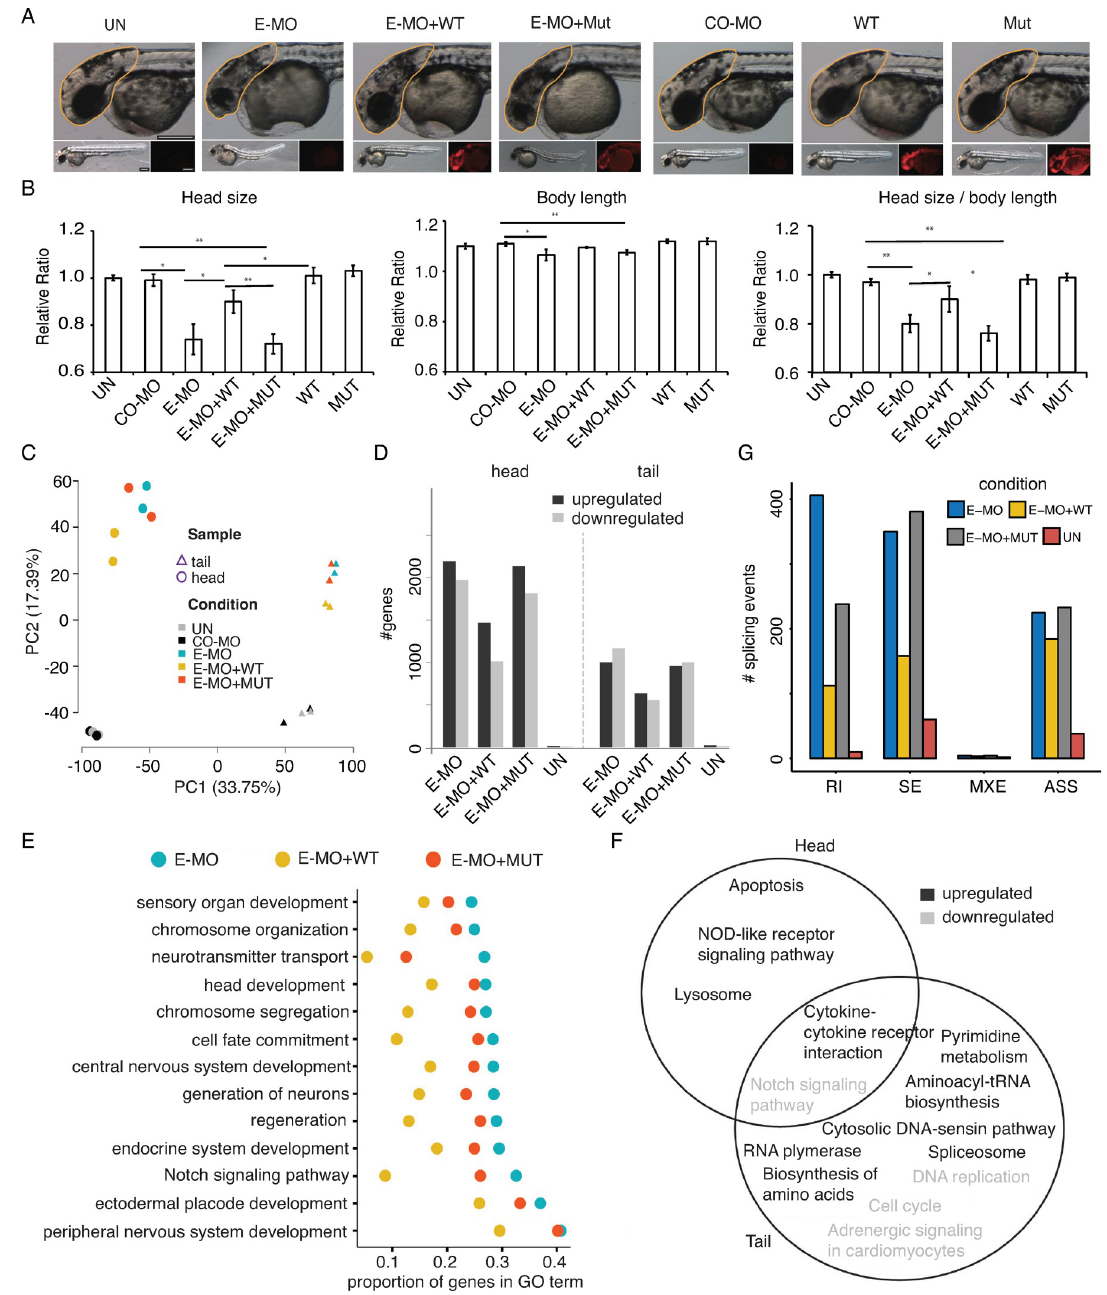
Fig 5. The SNPRE/SmE deficiency interferes with zebrafish brain development. (A), Measurement of zebrafish head size across different experimental conditions. CO-MO, control morpholino; E-MO, SmE morpholino. The morpholino and/or in vitro transcribed RNA are injected into embryo at 1-cell stage. Yellow line marked the region for quantification. (B), Quantification of zebrafish head size. Left, head size; middle, body length; right, head size normalized by body length. UN, un-injected; CO-MO, control morpholino; E-MO, SmE morpholino; WT, Wide type SmE gene in vitro transcript; Mut, mutant SmE gene in vitro transcript; The UN is normalized to 1. � P < 0.05; �� P < 0.01. (C), PCA analysis of the expression of 16067 protein coding genes (RPKM > 1) in zebrafish head and tail samples under different conditions. (D), Numbers of differentially expressed genes comparing to CO-MO. (E), Proportion of DEGs in 14 significant enriched dysregulated GO terms (biologic process, E-MO versus CO-MO, BH-adjusted p < 0.001). (F), Overlap of enriched dysregulated KEGG pathways (E-MO versus CO-MO, BH-adjusted p < 0.001) between zebrafish head and tail samples. G, Numbers of aberrant splicing events comparing to CO-MO.